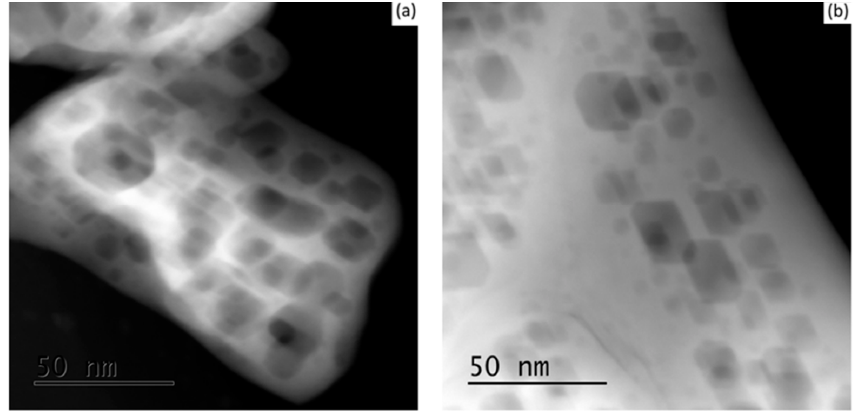
Figure 3. TEM images of 8 YSZ powder indicating YSZ particles containing pores after calcination at ( a ) 973 K and ( b ) 1373 K for 2 h.